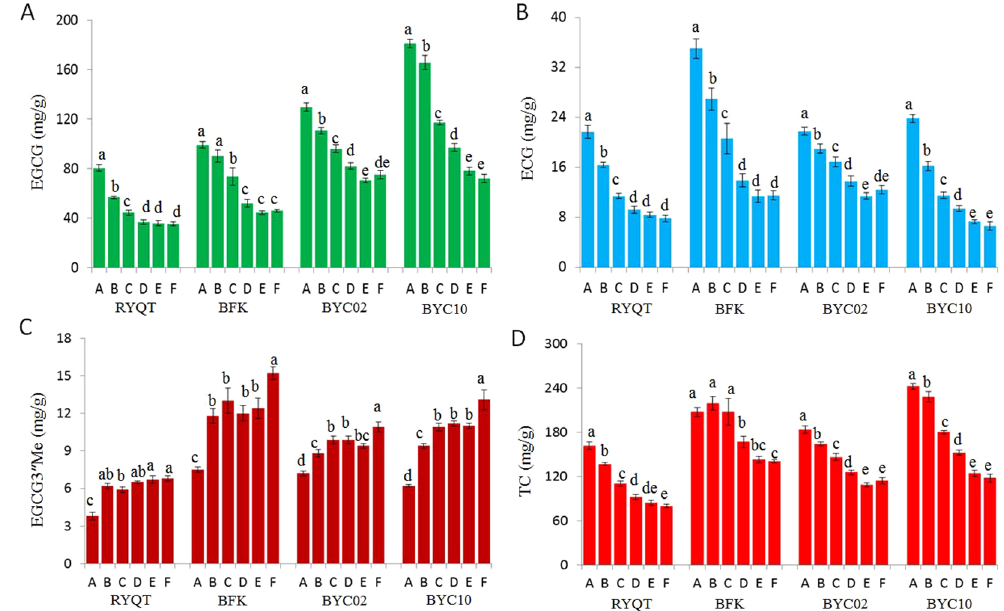
Figure 6. Catechin contents in different leaf position of ‘six and a bud’ tea shoots. ( A ) ( − )-epigallocatechin-3- gallate (EGCG), ( B ) ( − )-epicatechin-3-gallate (ECG), ( C ) 3 ″ -methyl-epigallocatechin gallate (EGCG3 ″ Me), ( D ) total catechins (TC). RYQT, ‘Ruyuan Qunti’; BFK, ‘Benifuuki’; BYC, ‘Baiyacha’. A. bud and first leaf; B. second leaf; C. third leaf; D. fourth leaf; E. fifth leaf; F. sixth leaf. The data are presented as the mean ± standard error of three independent analyses. Different letters above columns denote the existence of significant difference (p <